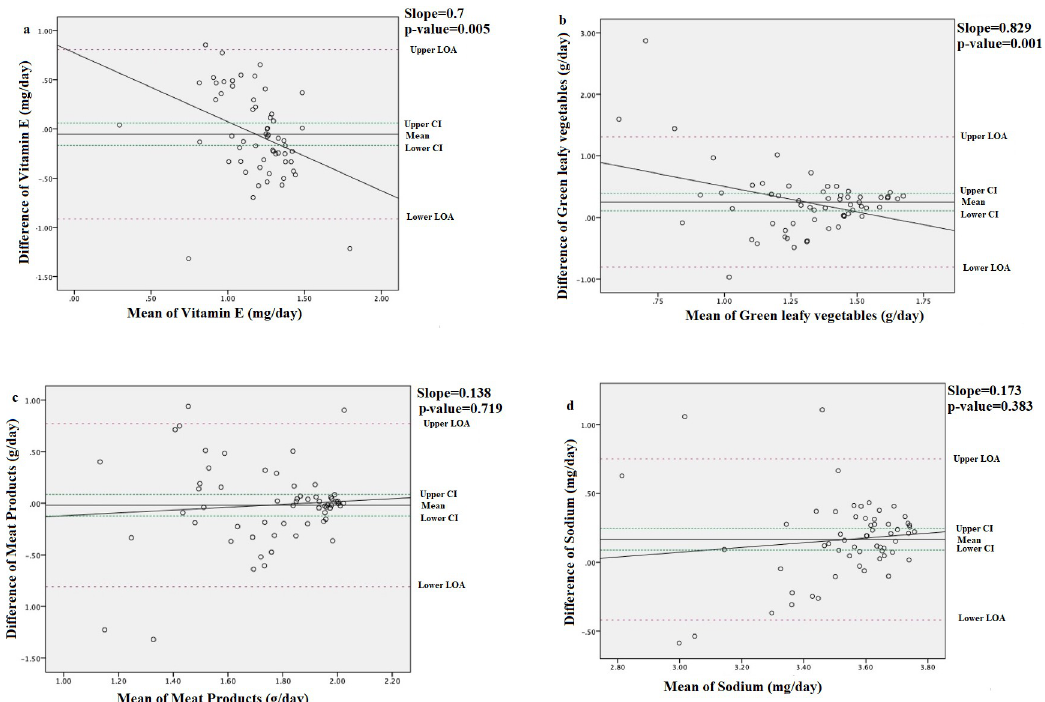
Fig 3. Bland–Altman plots for selected energy-adjusted nutrient and food group intakes showing the varying levels of agreement obtained between mean (ln) and differences in intakes measured by the AE-FFQ and the three 24HRs: (a) vitamin E (mg/day); (b) green leafy vegetables (g/day); (c) meat products(g/day); (d) sodium (mg/day). 24HR = 24-hour dietary recall; AE-FFQ = Adult Emirati food frequency questionnaire; ln = natural log.